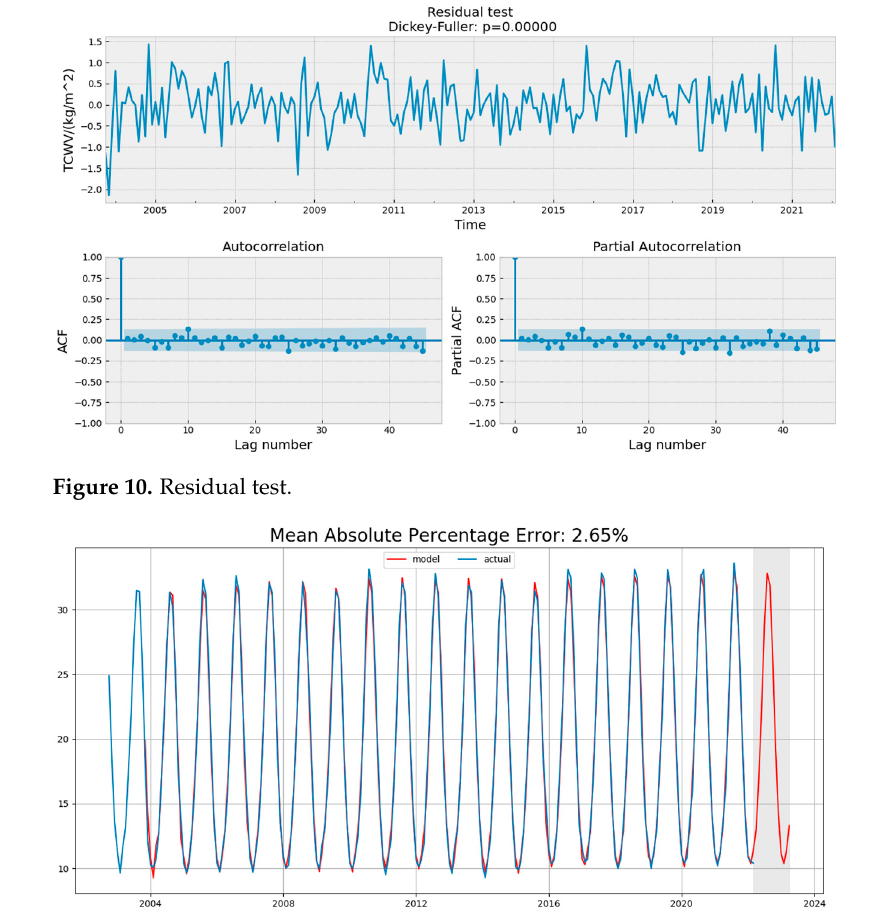
Figure 11. Prediction result of SARIMA